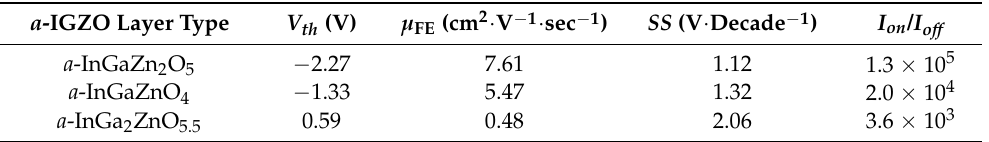
Figure 11. Transfer characteristics of TFT samples containing ( a ) a -InGaZn 2 O 5 , ( b ) a -InGaZnO 4 , and ( c ) a -InGa 2 ZnO 5.5 active channel layers subjected to the gate dielectric annealing at 300 ◦ C for 1 h in an ambient atmosphere. Table 5. Transfer characteristics of the three types of a -IGZO TFT samples subjected to the gate dielectric annealing at 300 ◦ C for 1 h in an ambient